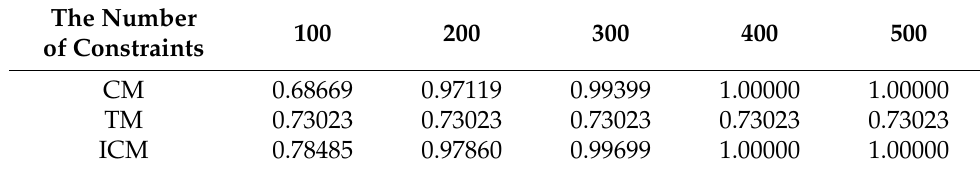
Table 1. Comparison of Adjusted Rand Index on dataset Iris.